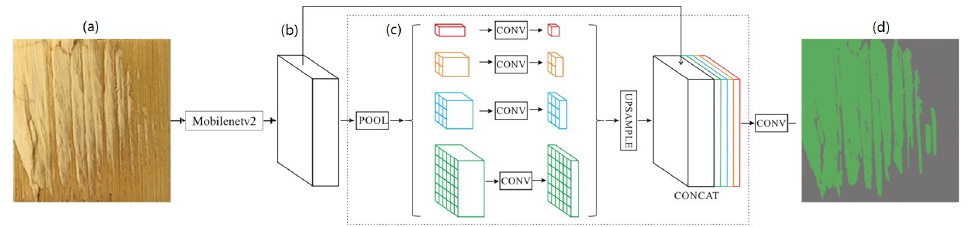
Figure 7. PSPNet model: ( a ) Input image; ( b ) Feature map; ( c ) Pyramid pooling module; ( d ) Final